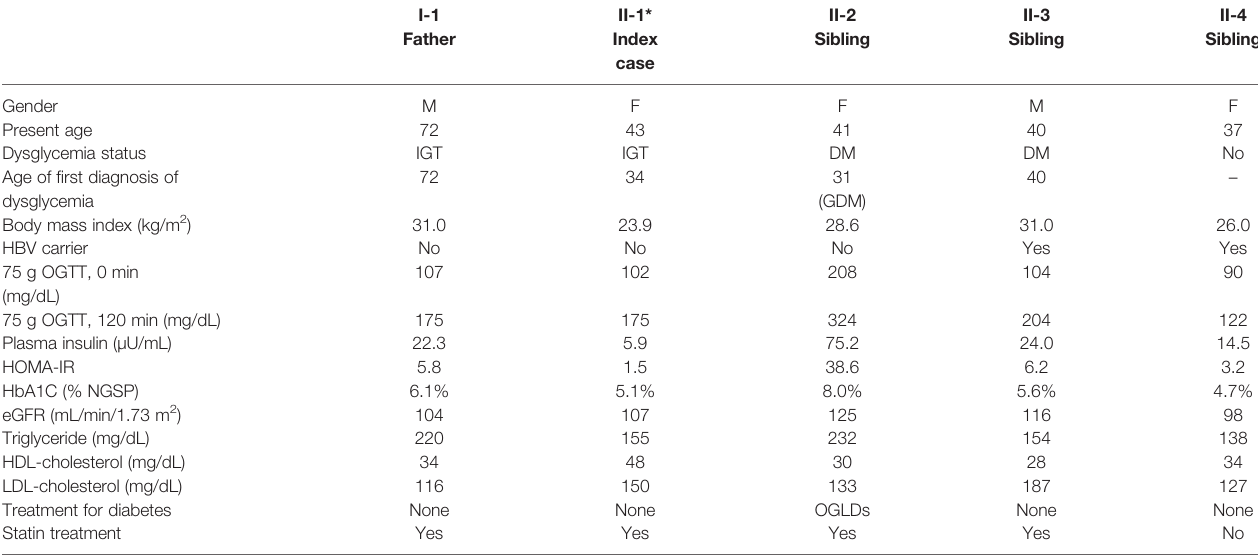
TABLE 1 | Detailed clinical and laboratory data in family members with